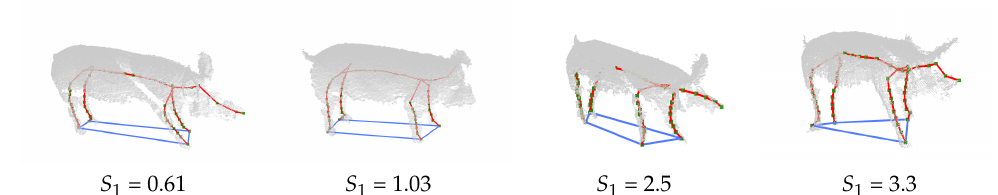
Figure 11. Illustration of pigs with different postures and their corresponding S1